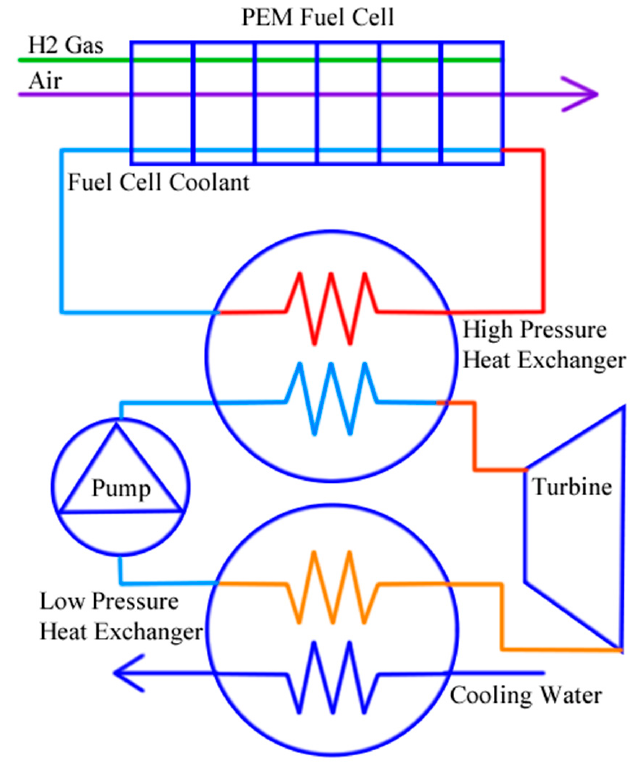
Figure 1. Diagram of the ORC and fuel cell setup.